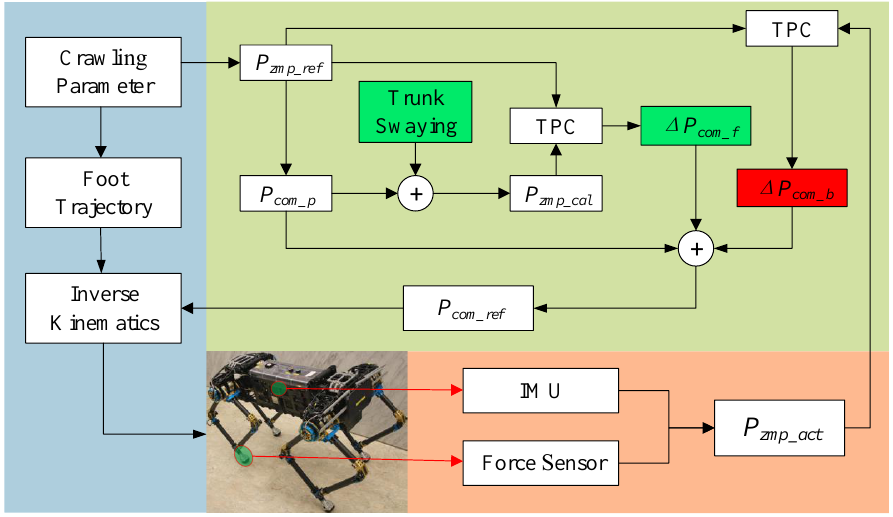
Figure 6. Crawling pattern generator based on trunk swaying. P zmp _ ref is the planned zero moment point (ZMP), which acts as the reference; P com _ p is the pre-theoretical center of mass (CoM) calculated based on P zmp _ ref ; P zmp _ cal is the calculated ZMP based on P com _ p and trunk swaying; ∆ P com _ f is the feedforward term of the CoM position based on trunk position compliance (TPC); P zmp _ act is the actual ZMP during real-time crawling according to the inertial measurement unit (IMU) and force sensors; ∆ P com _ b is the feedback term of the CoM position based on P zmp _ act ; and P com _ ref is the CoM reference trajectory.